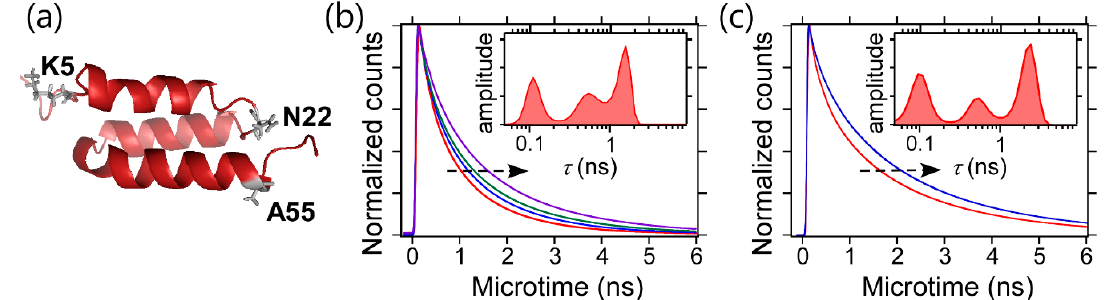
Figure 6. ( a ) NMR structure of B domain of protein A (PDB ID: 1SS1). The residues that were mutated to cysteine are shown by sticks. ( b ) Fluorescence decay curves of the FRET donor in the native state of K5C/Y15F/A55C mutant of BdpA at 1.0 (red), 2.0 (blue), 2.5 (green), and 3.0 M (purple) of guanidium hydrochloride (GdmCl). The corresponding independent lifetime distribution at 2.0 M GdmCl is also shown in the figure. ( c ) Fluorescence decay curves of the FRET donor in the unfolded state of Y15F/N22C/A55C mutant of BdpA at 2.0 (red) and 4.0 M (blue) of GdmCl. The corresponding independent lifetime distribution at 2.0 M GdmCl is also shown in the figure. In ( b , c ), these decay curves were obtained by performing a global 2D MEM analysis on the 2D emission-delay correlation maps at Δ T = 1–20, 50–100, and 400–600 µs. The arrows in ( b , c ) represent the shift of fluorescence decay curves with increasing GdmCl concentration. Adapted with permission from Ref. [44] Copyright 2017, American Chemical Society.